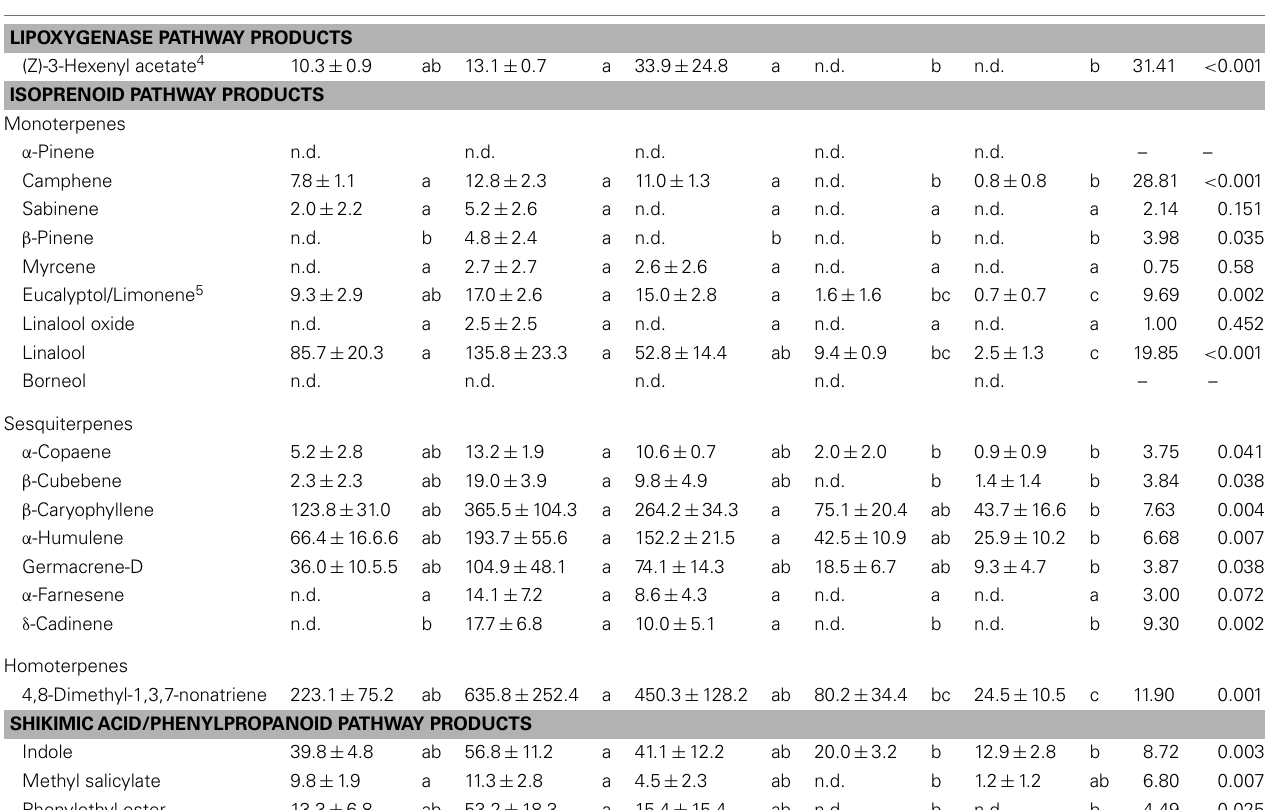
Table 3 |Time course of volatile emissions from cranberry, Vaccinium macrocarpon , plants sprayed with 1mM MeJA solution 1 .